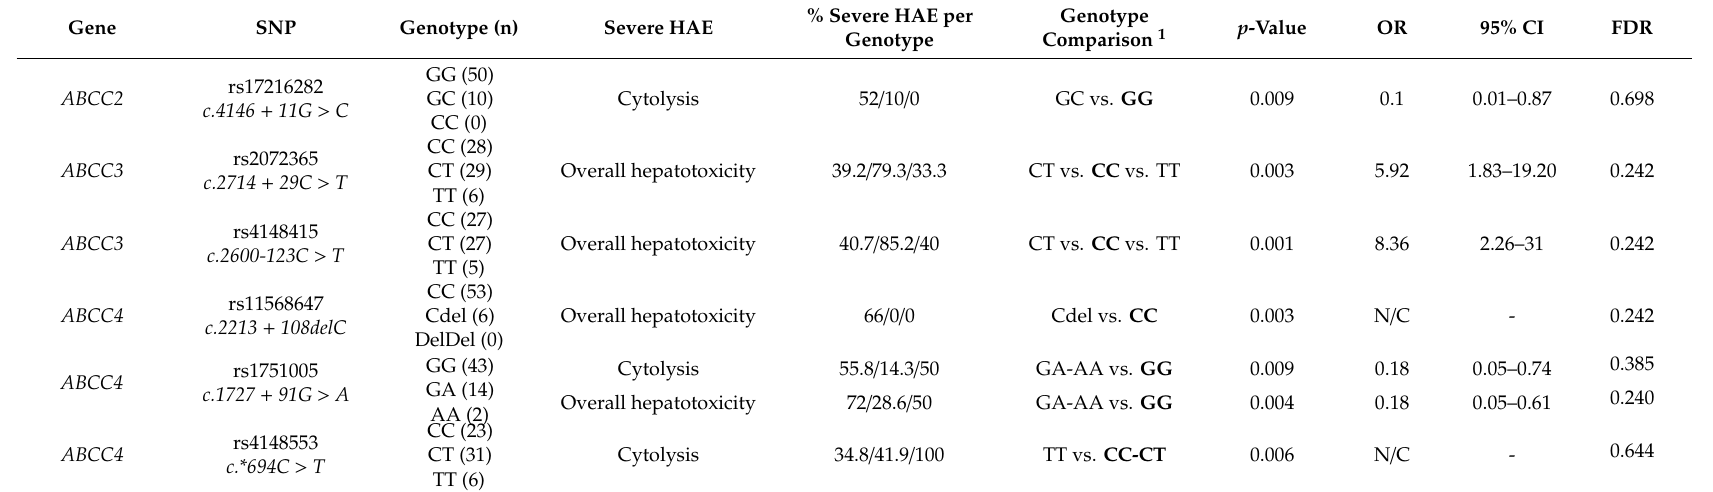
Table 3. Most significant results ( p < 0.01) of the univariate analysis conducted on the whole database of 208 SNPs genotyped by NGS (Next-Generation